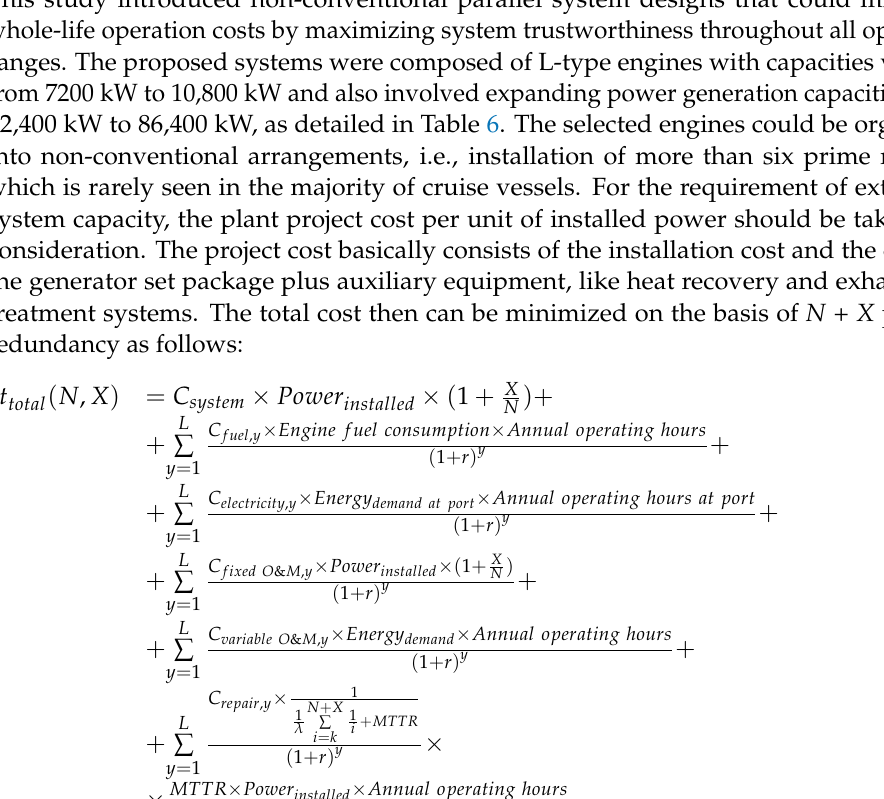
Figure 19. Annual repair costs of conventional configurations compared to load demands.